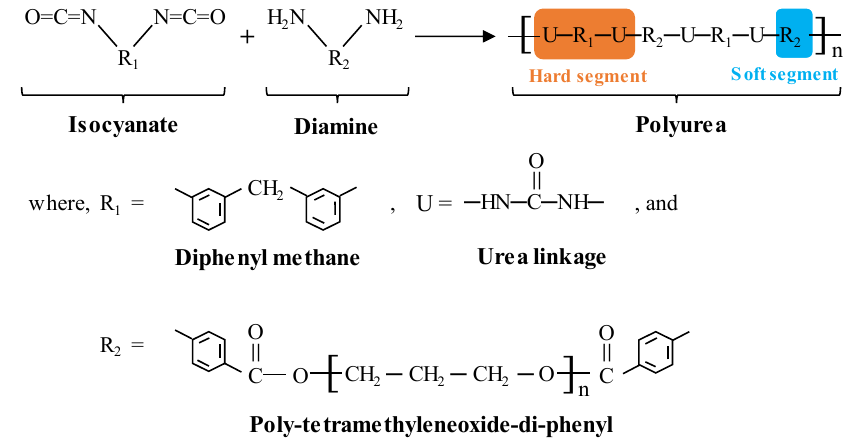
Schematic of the synthesis and chemical molecular structure of polyurea via the co-polymerization reaction of an isocyanate component and a synthetic resin blend. Fourier-transform infrared (Bruker Co., Karlsruhe, Germany) testing of the LINE-X 350